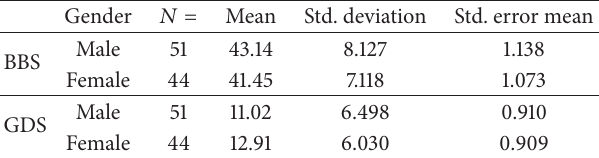
Table 3: Comparison between male and female with BBS and